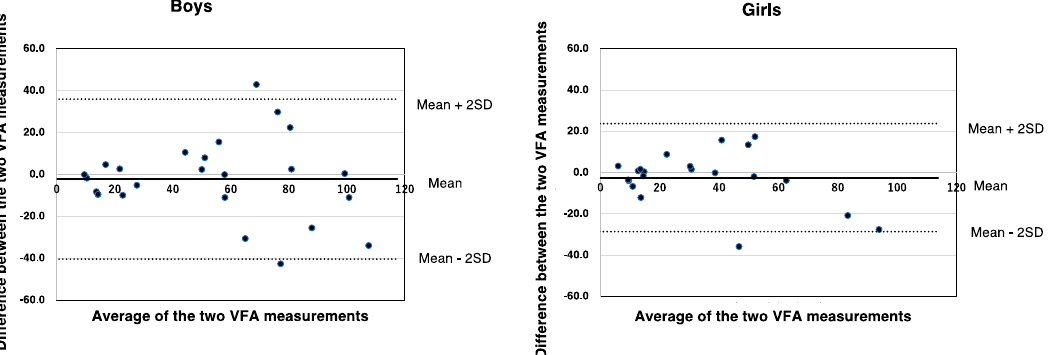
Figure 3. Correlation between corrected VFA-aBIA and VFA-CT in boys and girls. The corrected VFA-aBIA is VFA-aBIA corrected by the Passing–Bablok method: y = 9.600 + 0.3825x (boys) and y = 7.607 + 0.3661x (girls). VFA-aBIA—visceral fat area measured by abdominal bioelectrical impedance